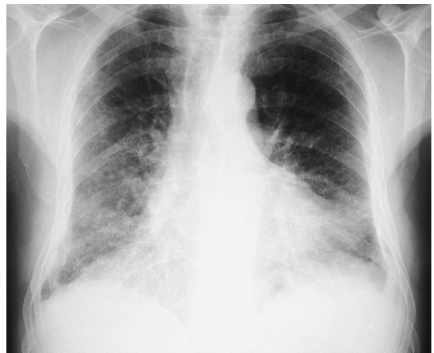
Figure 1: Chest X-ray of a patient diagnosed with combined pul- monary fibrosis and emphysema demonstrating bilateral interstitial pattern, predominantly right sided, with reticulonodular infiltrates in the lung bases and subpleural region, and a reduction of lung density in upper lung fields, mainly on the